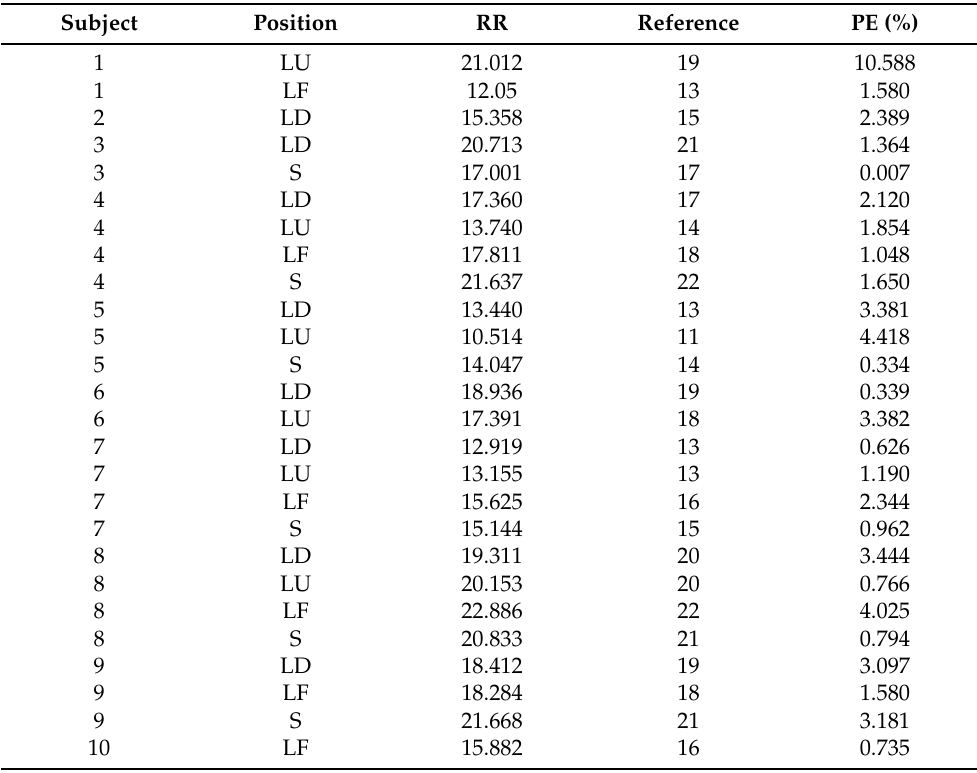
Table 6. Performance for all the subjects of the AHN model using MV as